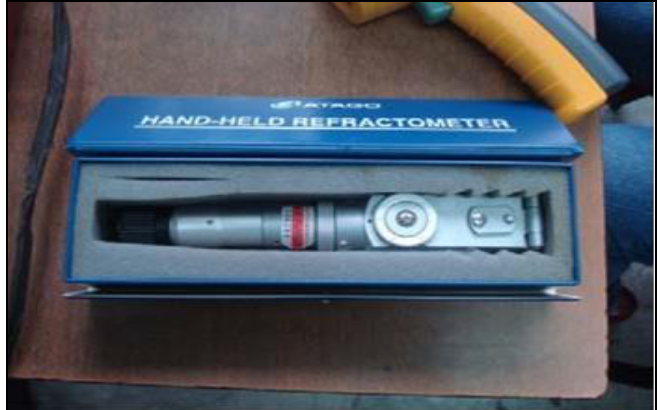
Figura 3: Refractómetro analógico.